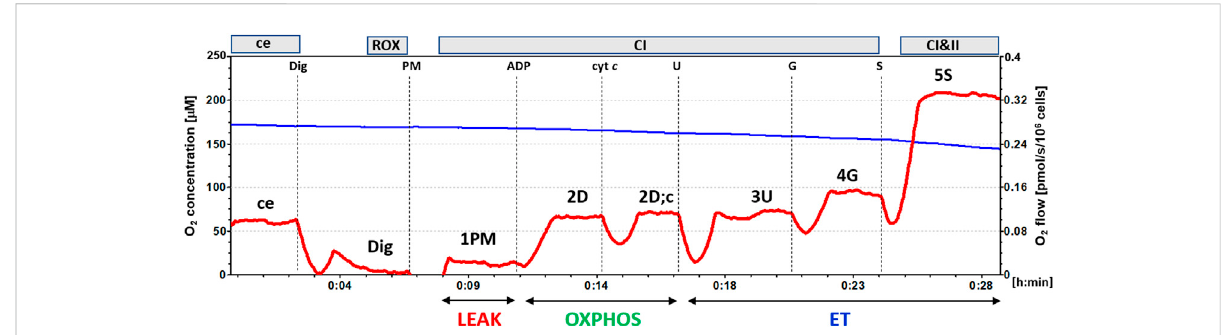
FIGURE 1 The trace from the measurement of platelet mitochondrial respiration following SUIT reference protocol 1 (Doerrier et al., 2018). The blue line represents oxygen concentration (µM), and the red trace oxygen consumption as fl ow per cells (pmol O 2 /s/10 6 cells). The protocol includes following titration steps: ce — cells; Dig — Digitonin; PM — pyruvate + malate; ADP; cyt c — cytochrome c; U — the uncoupler FCCP; G — glutamate; S — succinate. All substrates were titrated in kinetically saturating concentrations, uncoupler FCCP was titrated in optimum concentration for evaluation of maximum O 2 fl ow at given titration step. The evaluated respiratory capacities are marked according to the titration steps in the reference protocol1andcorrespondtofollowingrespiratorystates:ce — routinerespirationofintactcells;Dig —